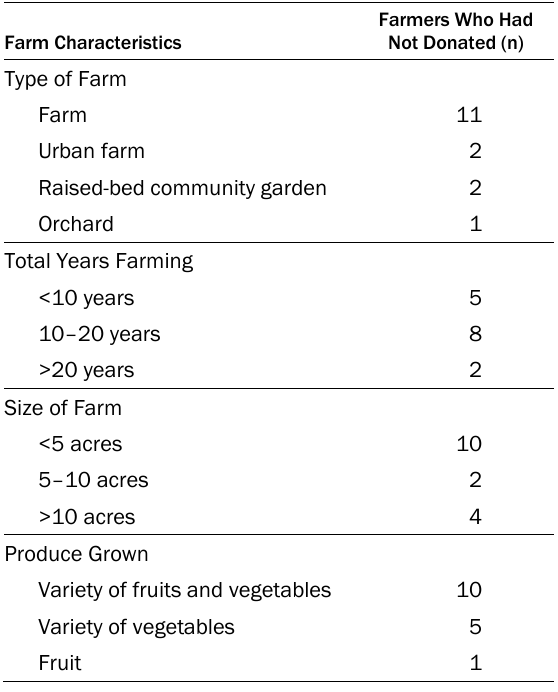
Table 4. Farm Characteristics for Farmers Who Had Not Participated in Gleaning